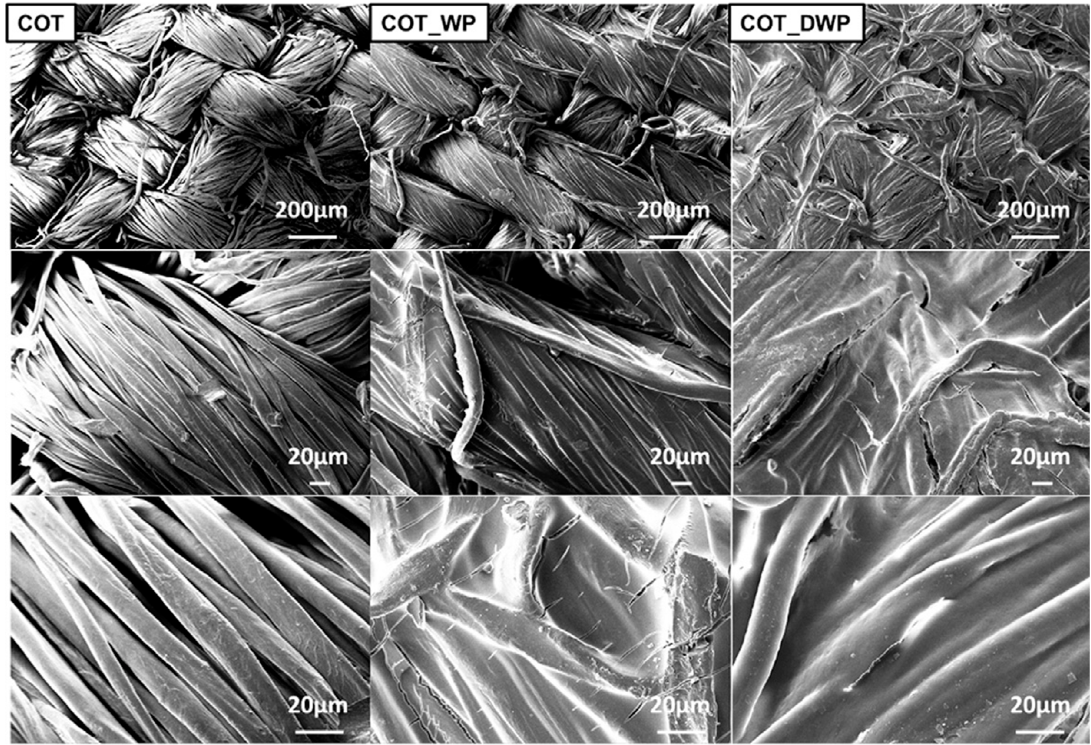
Figure 1. SEM magnifications of cotton (COT), cotton treated with folded (COT_WP) and denatured (COT_DWP) whey proteins. Reproduced with permission from [32]. Copyright 2013,